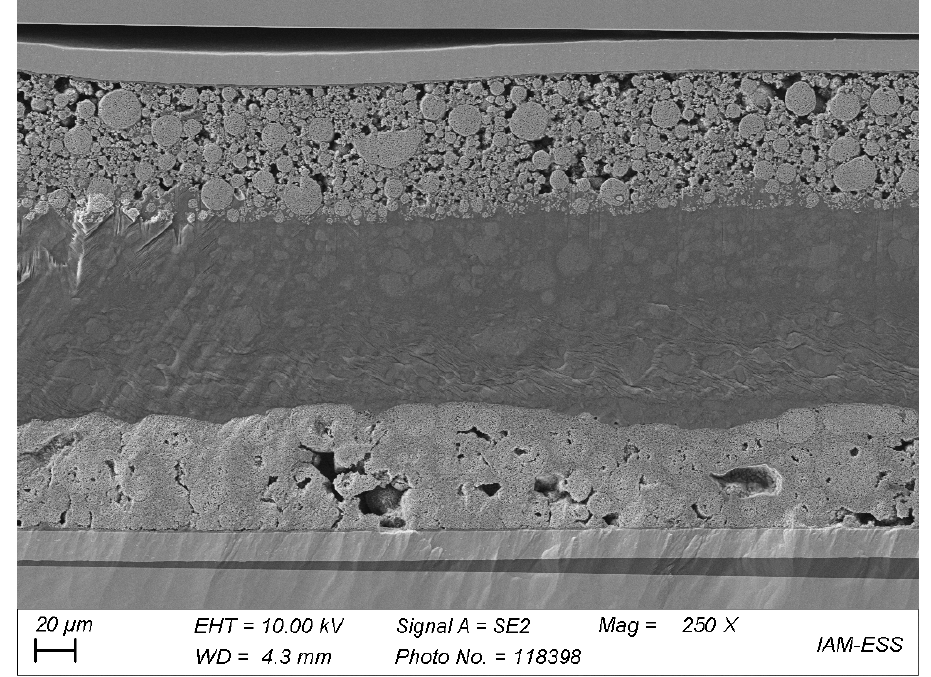
Figure 11. Scanning electron microscope image of the cross-section of a cell stack, post mortem after cycling at 70 °C, with PIL_7_6 coated LiFePO 4 and Li 4 Ti 5 O 12 electrodes; 250× magnification.